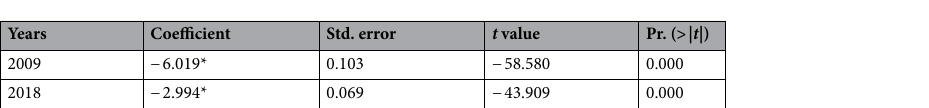
Table 3. Global regression analyses of LST on NPP ind (OLS model). * Indicates a statistically significant p -value ( p < 0.01).